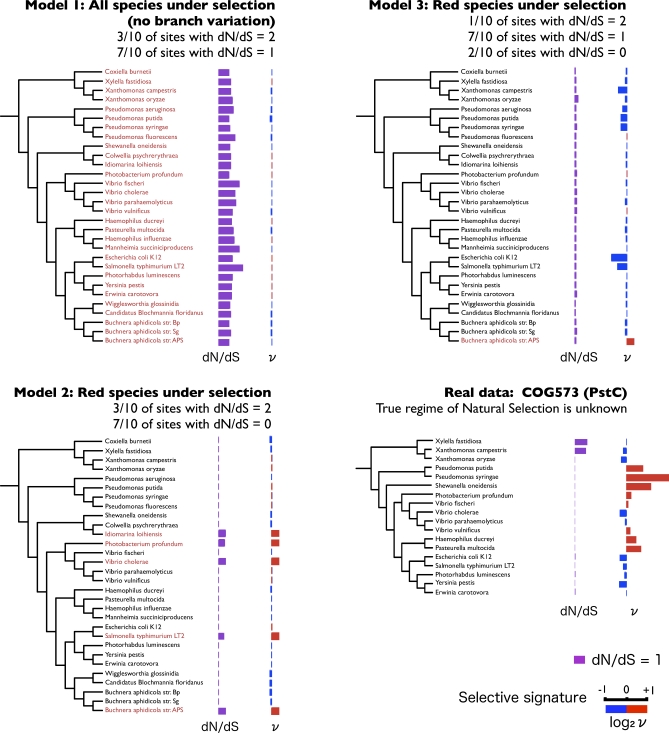
Detection of Positive Selection by dN/dS and ν under Different Evolutionary ModelsValues of dN/dS and ν (mean over 12 replicates of each model) are shown for three simulation models. Model 1: dN/dS = 2 at 3/10 of sites and dN/dS = 1 at 7/10 of sites, in all species (shown in red). Model 2: dN/dS = 2 at 3/10 of sites and dN/dS = 1 at 7/10 of sites, respectively, for the species shown in red. All other branches had dN/dS = 0 at all sites. Model 3: dN/dS = 2, dN/dS = 1, and dN/dS = 0 at 1/10, 7/10, and 2/10 of sites, respectively, in the species shown in red. All other branches had dN/dS = 1 and dN/dS = 0 at 8/10 and 2/10 of sites, respectively. Values of dN/dS and ν are also shown, as estimated for a real protein family from our dataset of 744 protein families in 30 species.